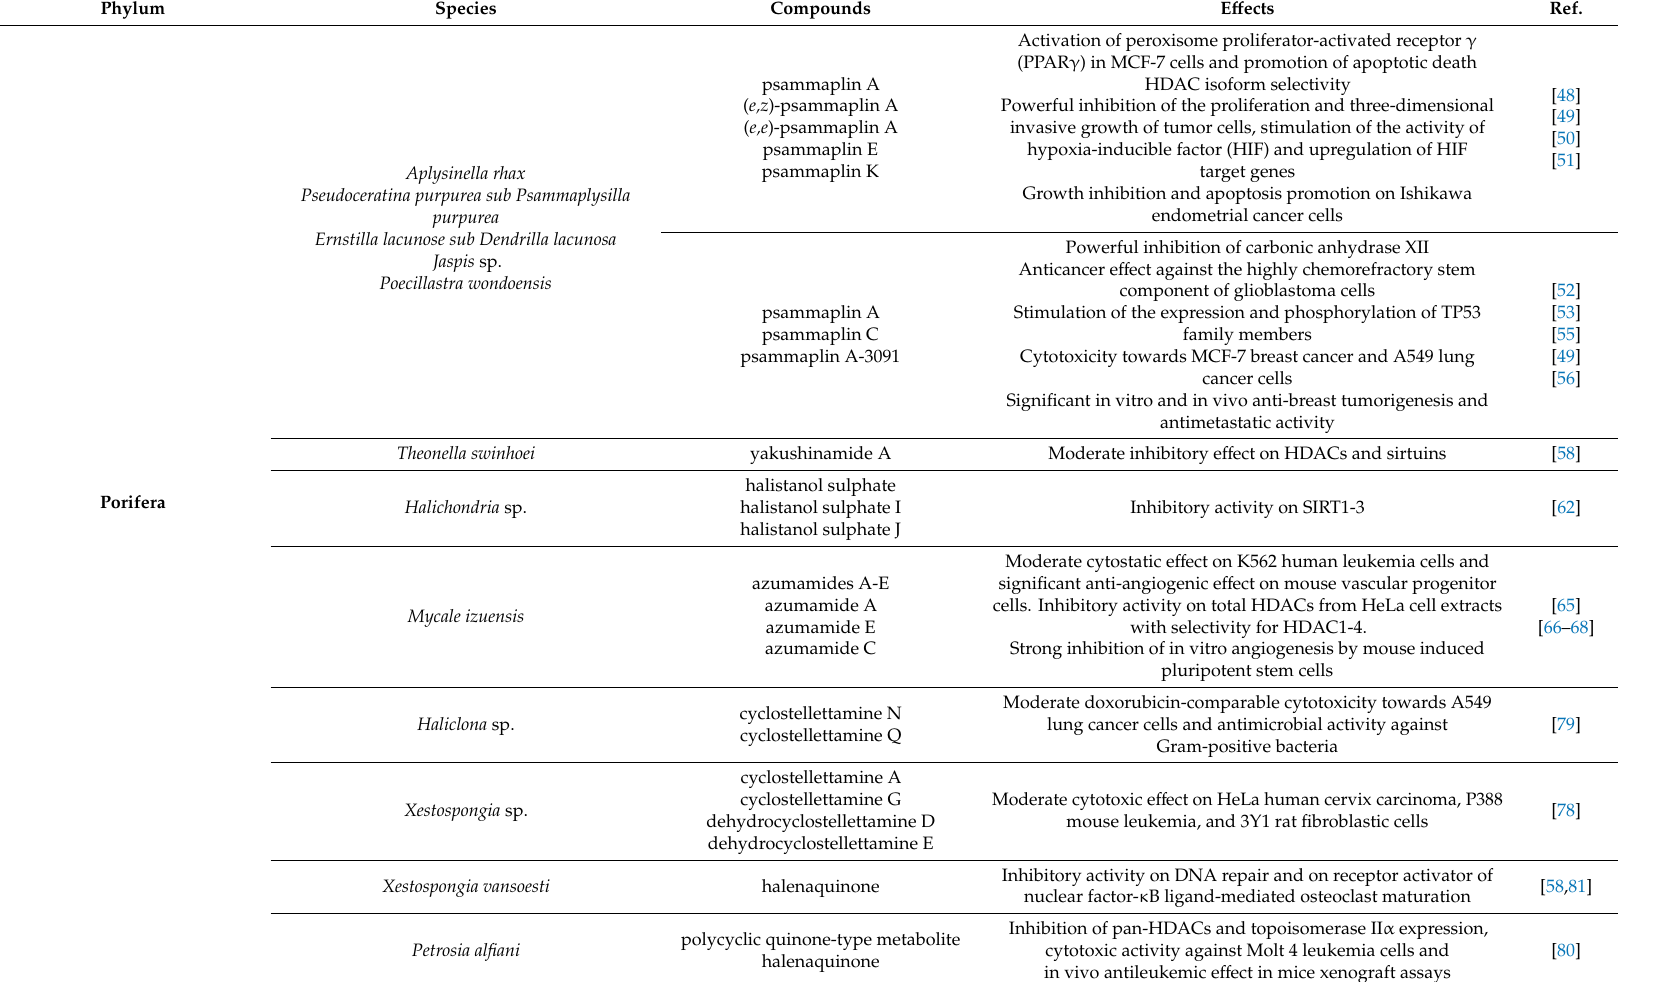
Table 2. Properties of HDACis from marine